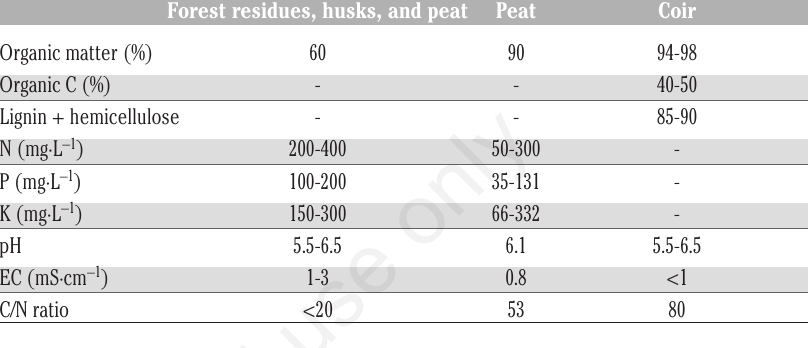
Table 1. Physical and chemical characteristics of three commercial substrates.